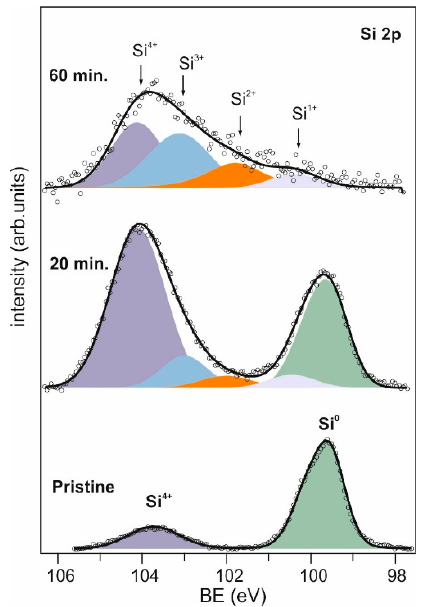
Figure 5. Si 2p core level spectra of pristine SiO 2 /Si substrate and MoS 2 thin film after 20- and 60-min deposition and annealing at 400 °C.